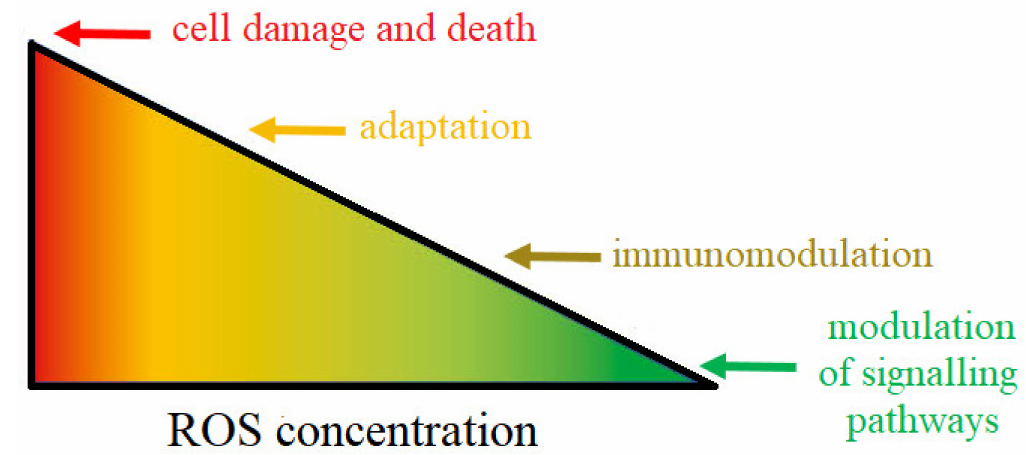
Figure 1. Under conditions of homeostasis, reactive oxygen radicals are released in amounts safe for the cell and can induce cell differentiation and apoptosis, influence the synthesis, release or inactivation of nitric oxide, and stimulate glucose transport to cells. By increasing the permeability of the capillary walls, they ensure the proper course of the inflammatory reaction. One of the most important tasks performed by ROS is the regulation of the processes of signal transmission from cell to cell and within it. Higher concentrations of these molecules cause toxic cell damage, leading to their destruction. The harmful effect of free oxygen radicals is manifested, among others, by their ability to oxidise proteins, nucleic acids and lipids